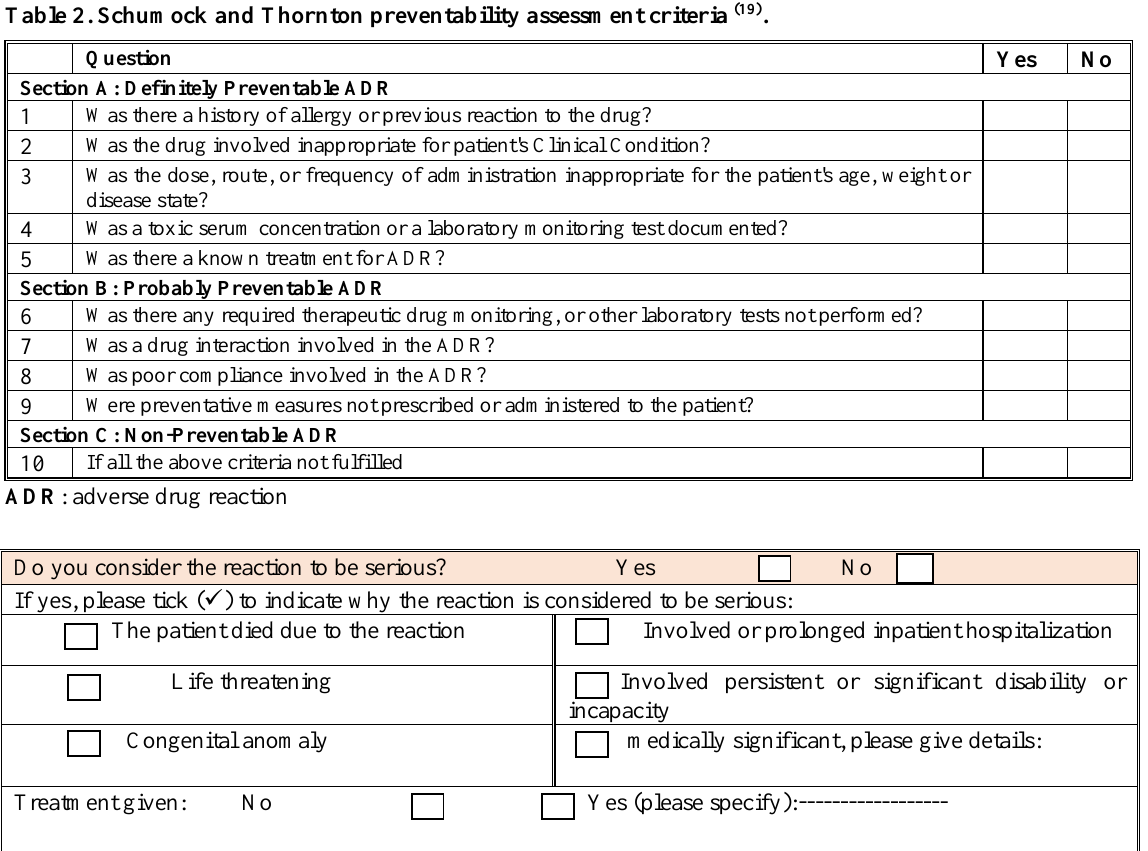
Figure 1. Seriousness assessment in the Individual Case Safety Report (20)